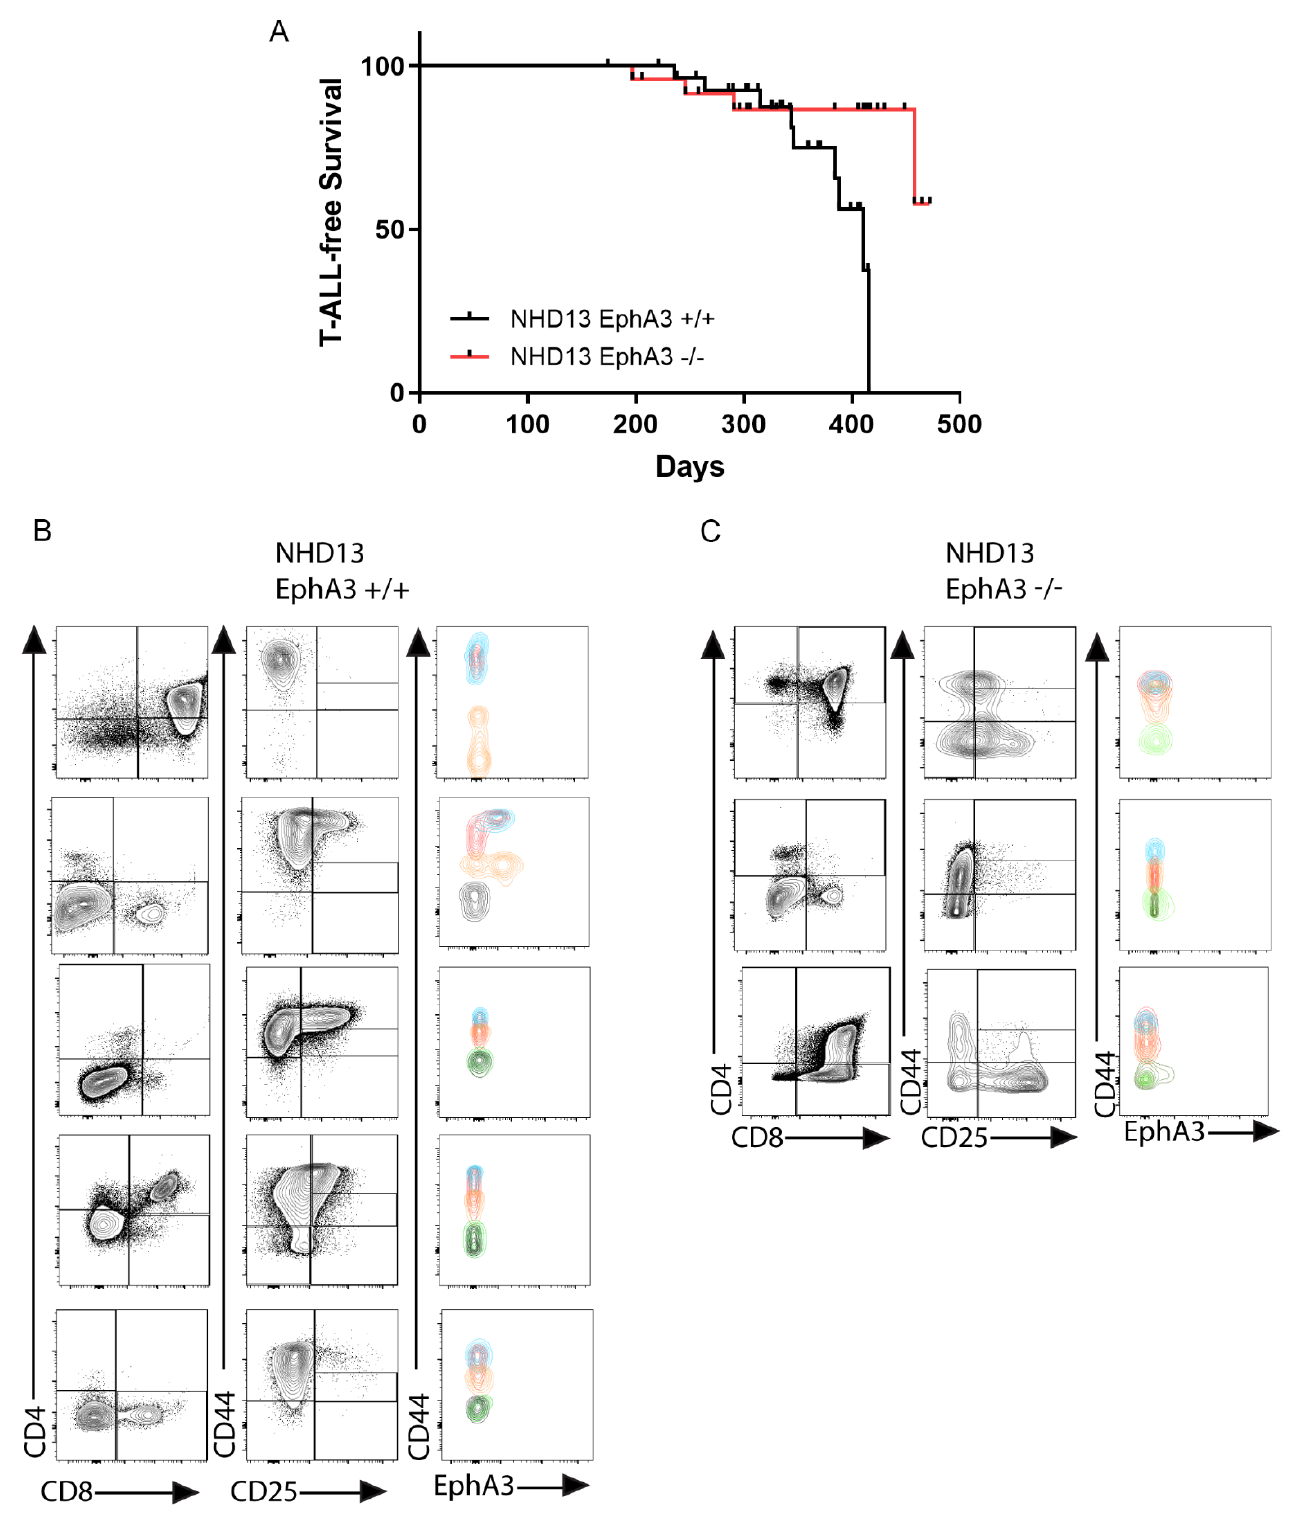
Figure 3. EphA3 deletion reduces T-ALL incidence in NHD13 mice. ( A ) Kaplan – Meier plot of T-ALL-free survival for each indicated genotype, with deaths due to causes other than T-ALL excluded. ( B, C ) Representative cell profiles and EPHA3 detection in T-ALL leukaemias of (B) NHD13 EphA3 +/+ and (C) NHD13 EphA3 -/- mice, using CD4/CD8, CD44/CD25, and CD44/EPHA3. The colour of the contour plots matches the colour of the gated DN1-4 populations from Figure 1B.